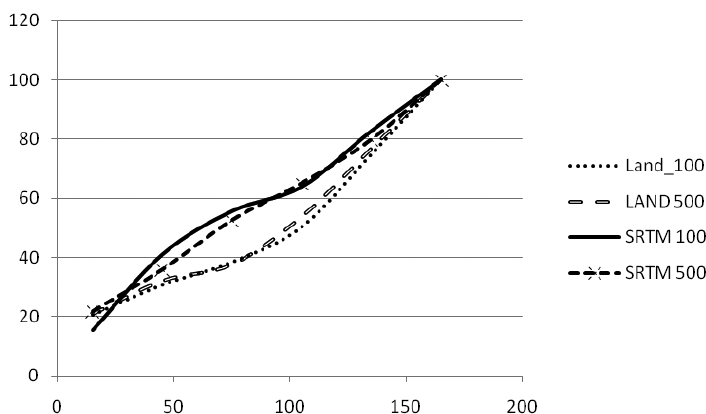
Figure 5 - Accumulated frequency used to compare the scales of the